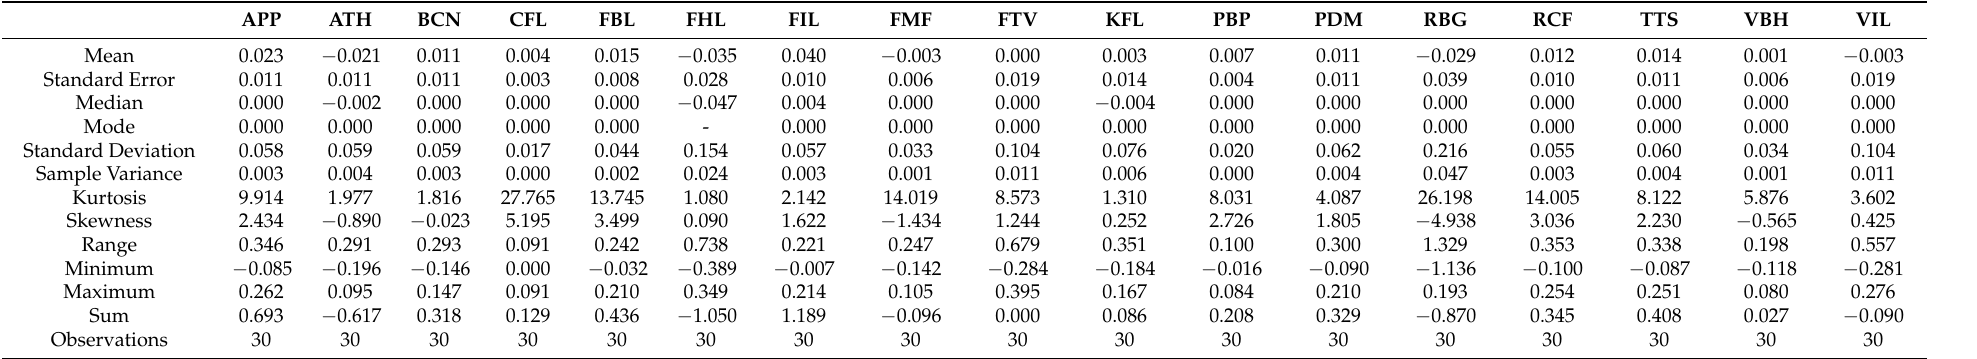
Table 11. Descriptive Statistics of Monthly Stock